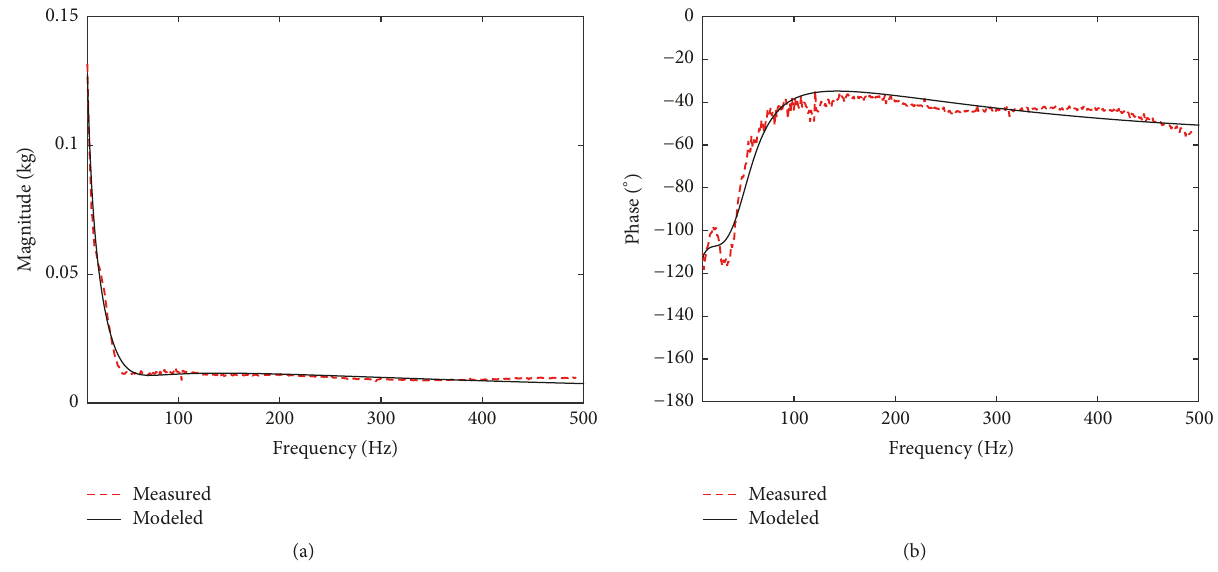
Figure 7: Comparison of the one-phalanx measurement and 1-Phalanx model apparent mass: (a) magnitude; (b) phase.